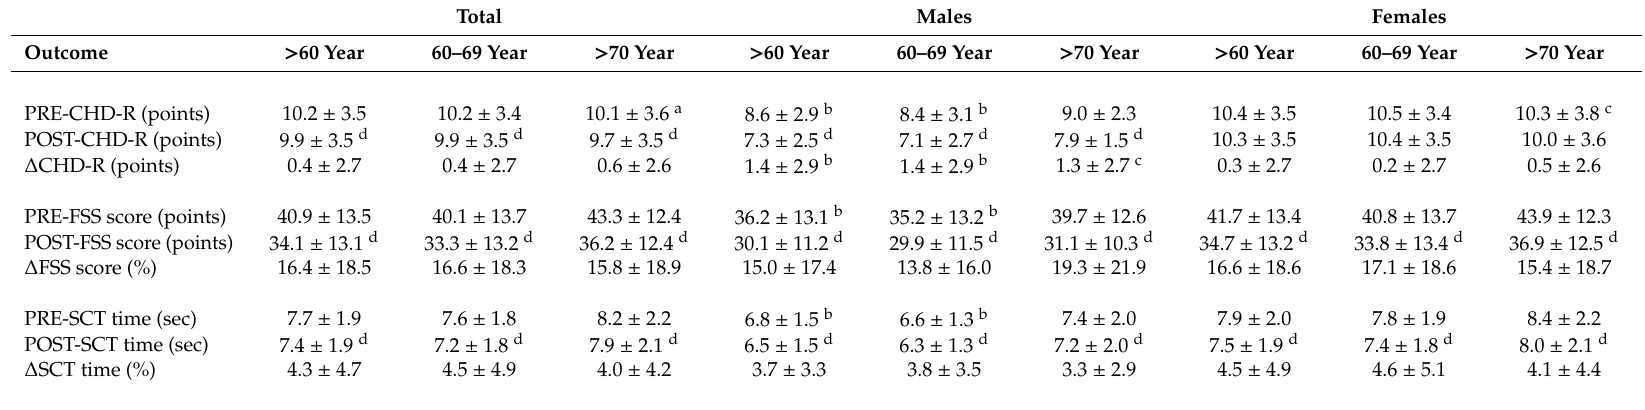
Table 3. CHD-R, FSS score and SCT time in the study population (before and after